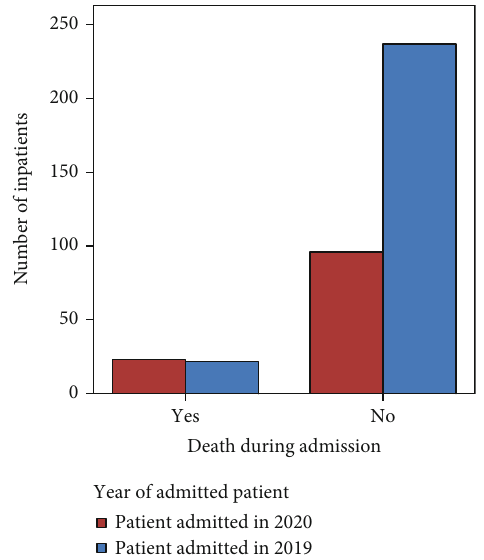
Figure 3: Mortality in 2019 and 2020 during